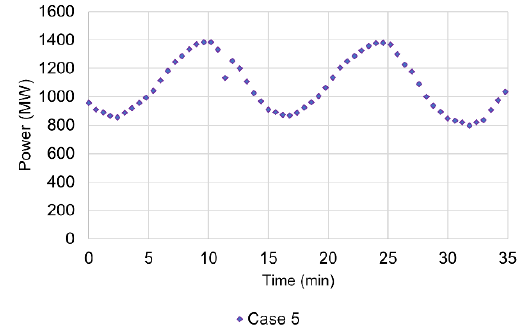
Figure 16. Modified electricity demand load for Case 5.